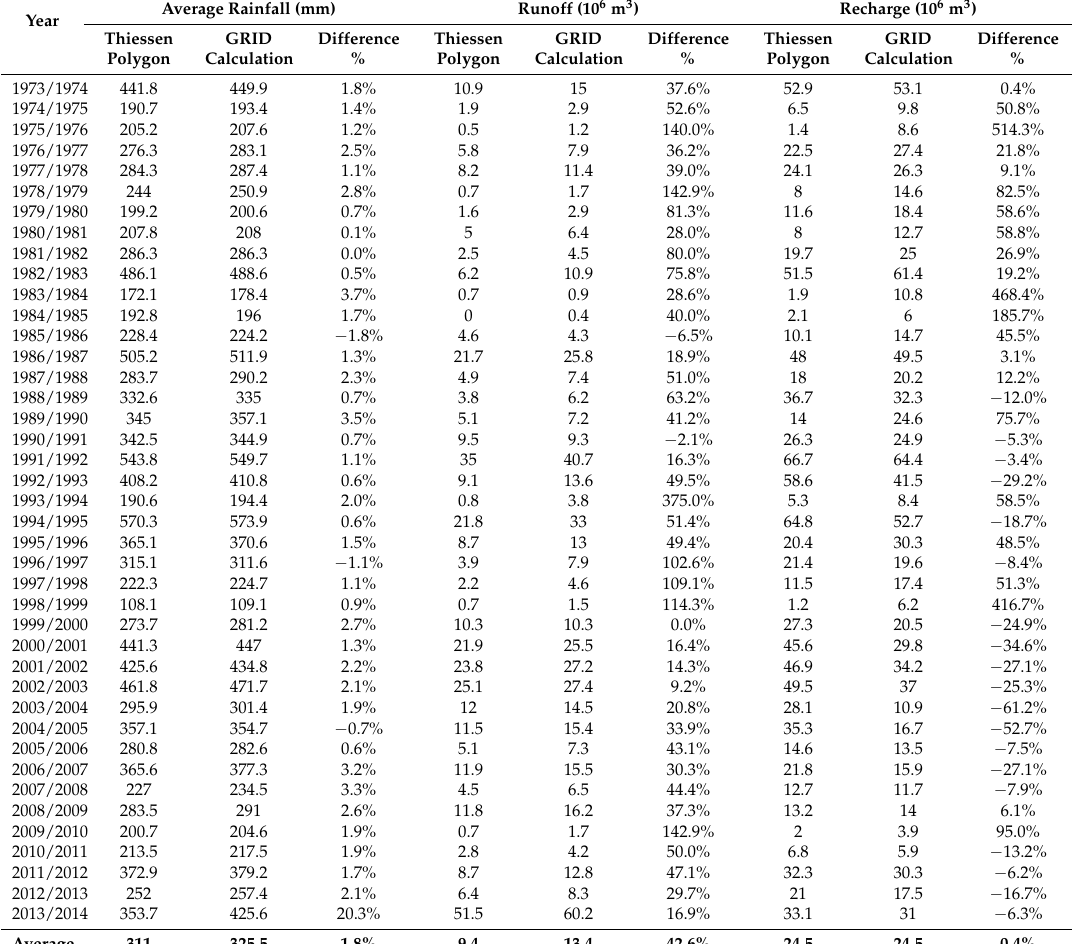
Table 6. Comparison between Thiessen polygon method and GIS GRID method on a yearly